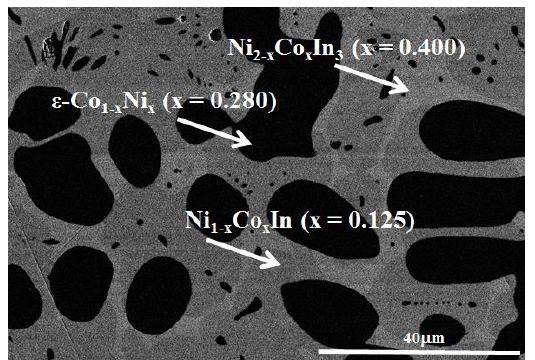
Figure 10. BSE micrograph of the sample Ni 1 − x Co x In (x = 0.14).